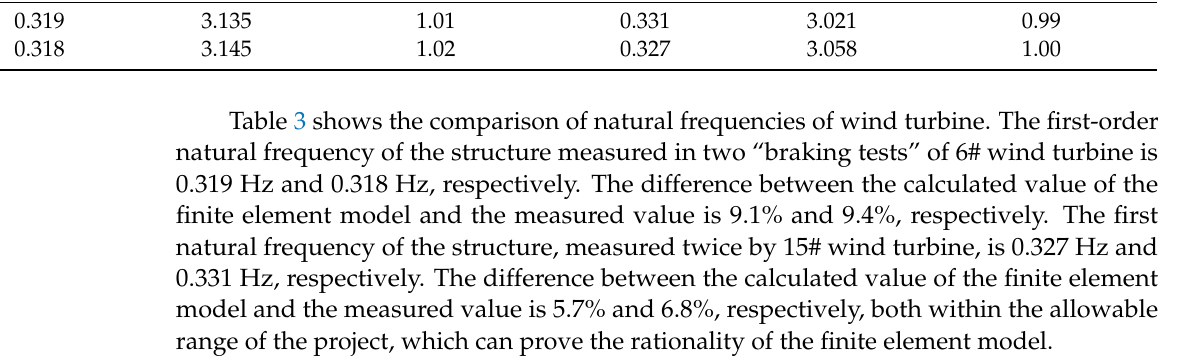
Table 3. Comparison of natural frequencies of wind turbine.